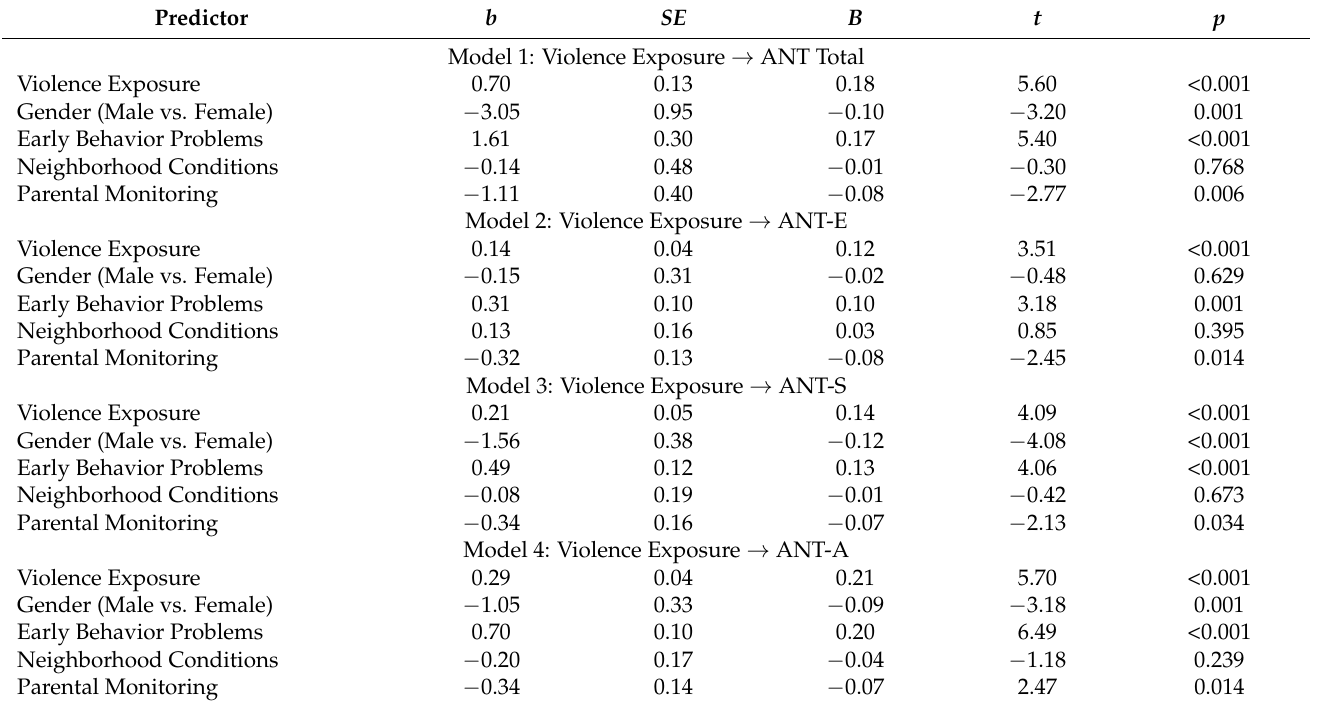
Table 3. Multiple Linear Regression Models Estimating the Effect of Violence Exposure on Antiso- cial